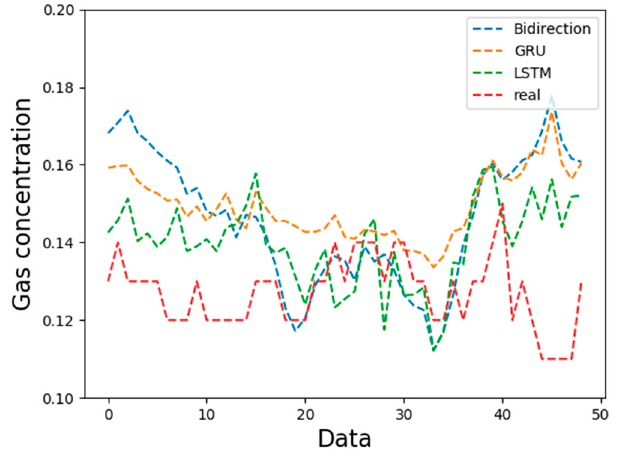
Figure 17. Comparison of prediction results for three models.